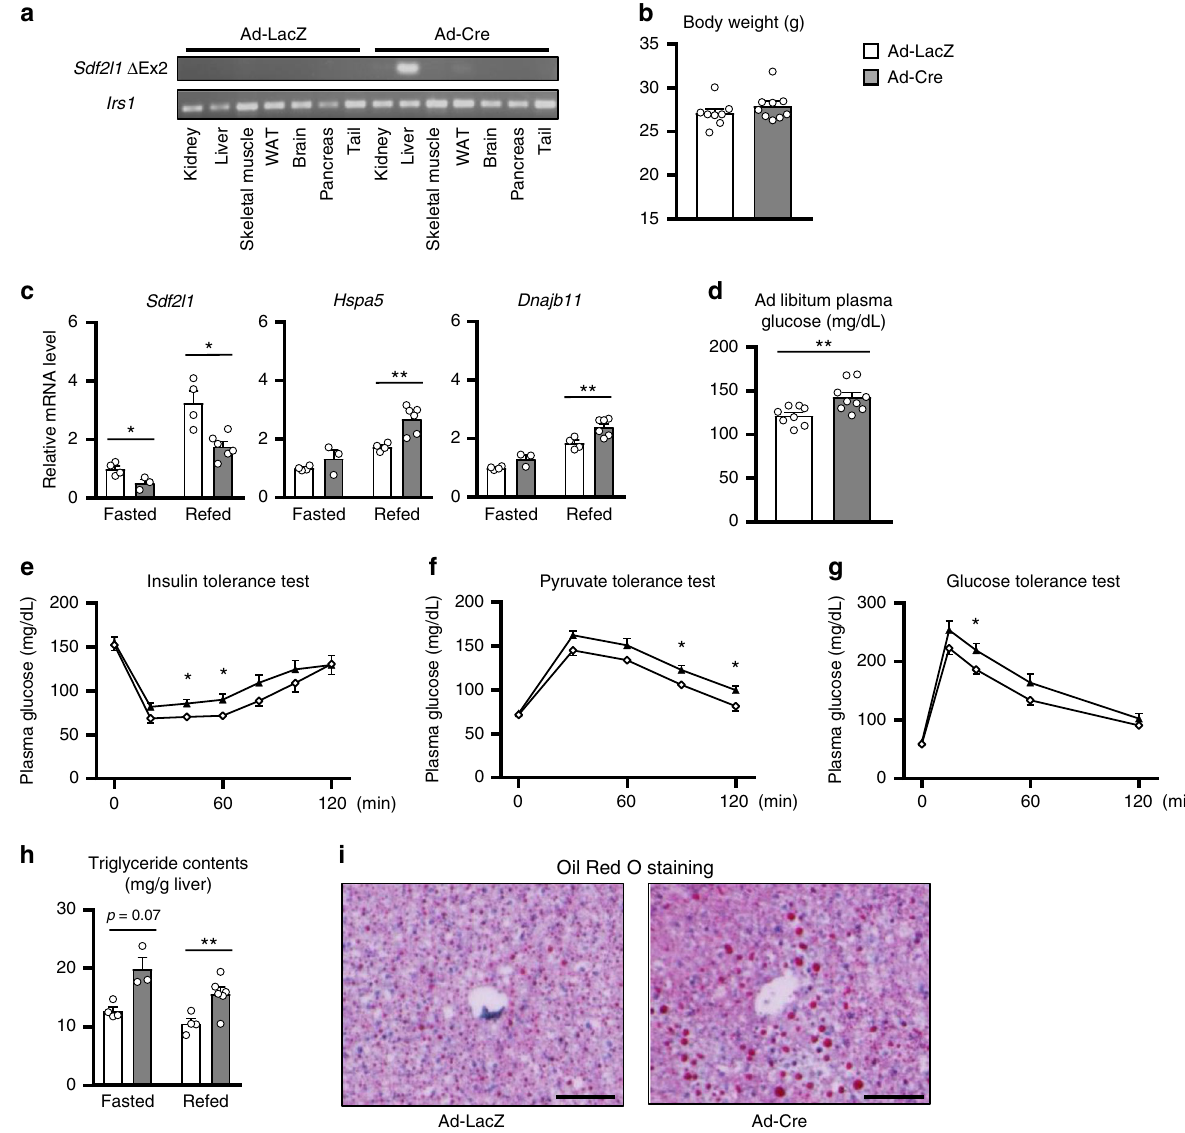
Fig. 4 Generation and phenotypes of the knock out model of Sdf2l1 . Sdf2l1 - fl oxed mice were administered with Ad-Cre (3.0 × 10 7 PFU/g BW), to generate a liver-speci fi c Sdf2l1 knockout model in adults. a Detection of deleted exon 2 of the Sdf2l1 gene by PCR. b , d – i Metabolic phenotypes analyzed 3 – 6 weeks after the adenovirus administration ( n = 8 – 9): b body weight, d ad libitum-fed plasma glucose, e plasma glucose in insulin tolerance test (ITT), after intraperitoneal injection of human regular insulin (0.75 U/kg BW), f plasma glucose levels in an pyruvate tolerance test, after intraperitoneal injection of pyruvate (1.5 g/kg BW), g plasma glucose levels in an oral glucose tolerance test (OGTT), after oral administration of glucose (0.75 g/kg BW), following 16 h of fasting. c ER stress in the liver ( n = 3 – 6), analyzed by RT-PCR. h , i Effects on lipid metabolism, analyzed with h triglyceride contents quanti fi cation ( n = 3 – 6), and i Oil Red O staining. Values of the data are expressed as mean ± SEM. * P < 0.05, ** P < 0.01. Unpaired 2-tailed t -test was used for assessment. Scale bars: 100 μ